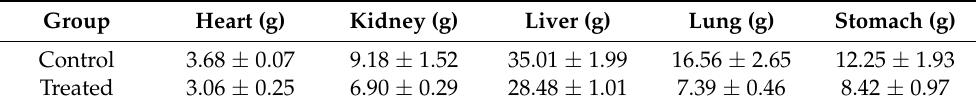
Table 7. Weight variation of vital organs after oral administration of hydrogels. All values are expressed in the standard deviation ( n = 6).